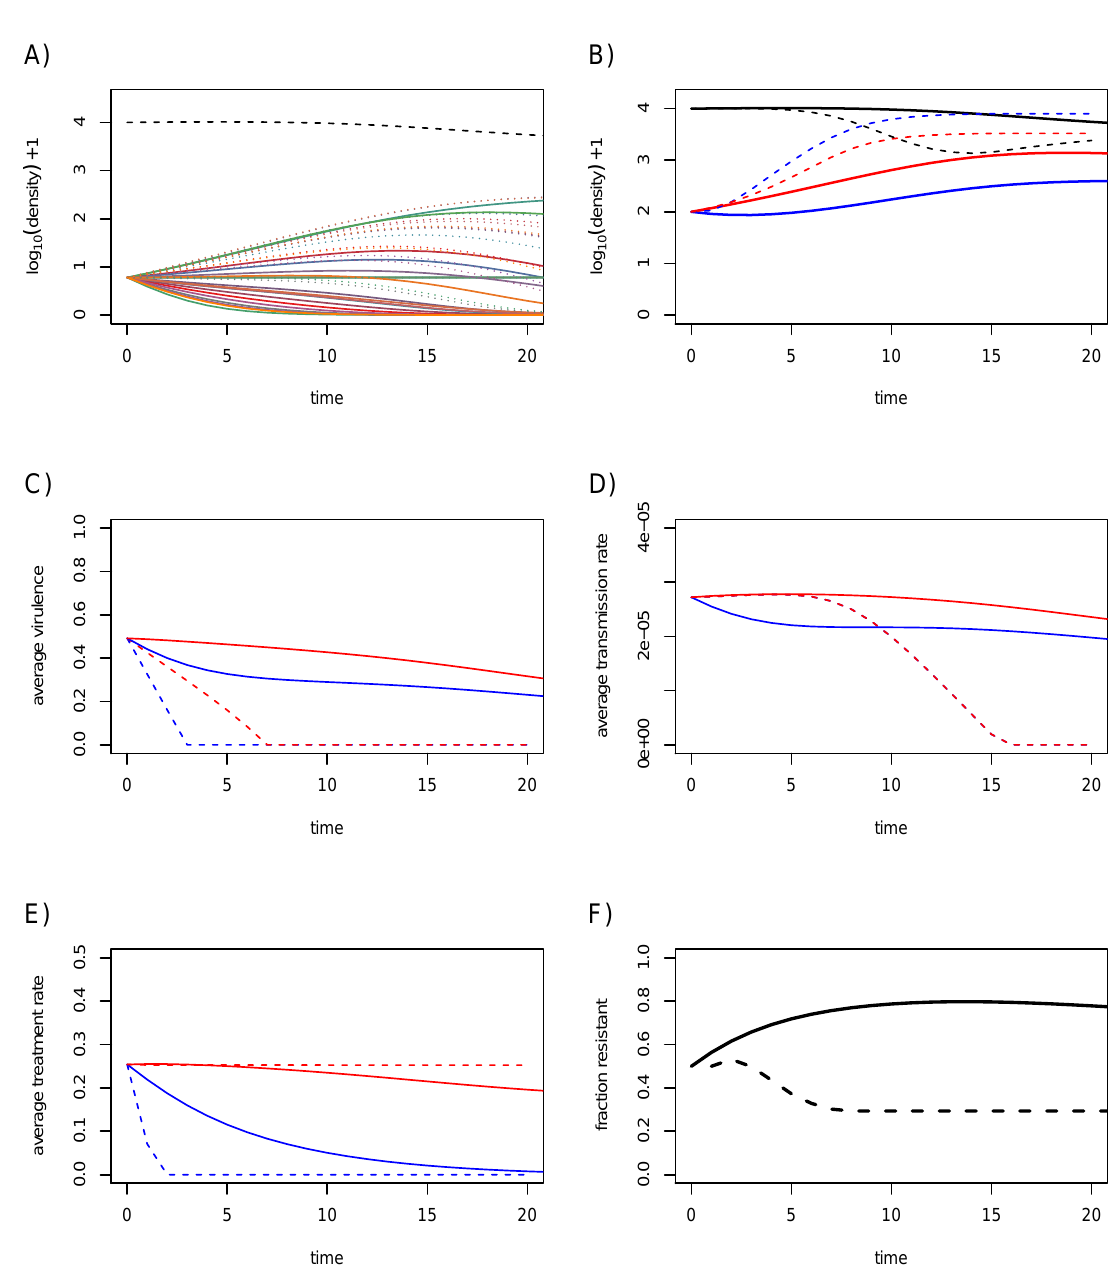
Figure S1 – Short-term dynamics with pre-existing drug resistance. Virulence in the drug-resistant compartment still decreases more slowly than in the drug-sensitive com- partment if we assume that the initial density of the two types of infections is equal (therefore that drug resistance is not only generated by treatment failure initially). I R i = 5 and other parameter values are identical to that in the main